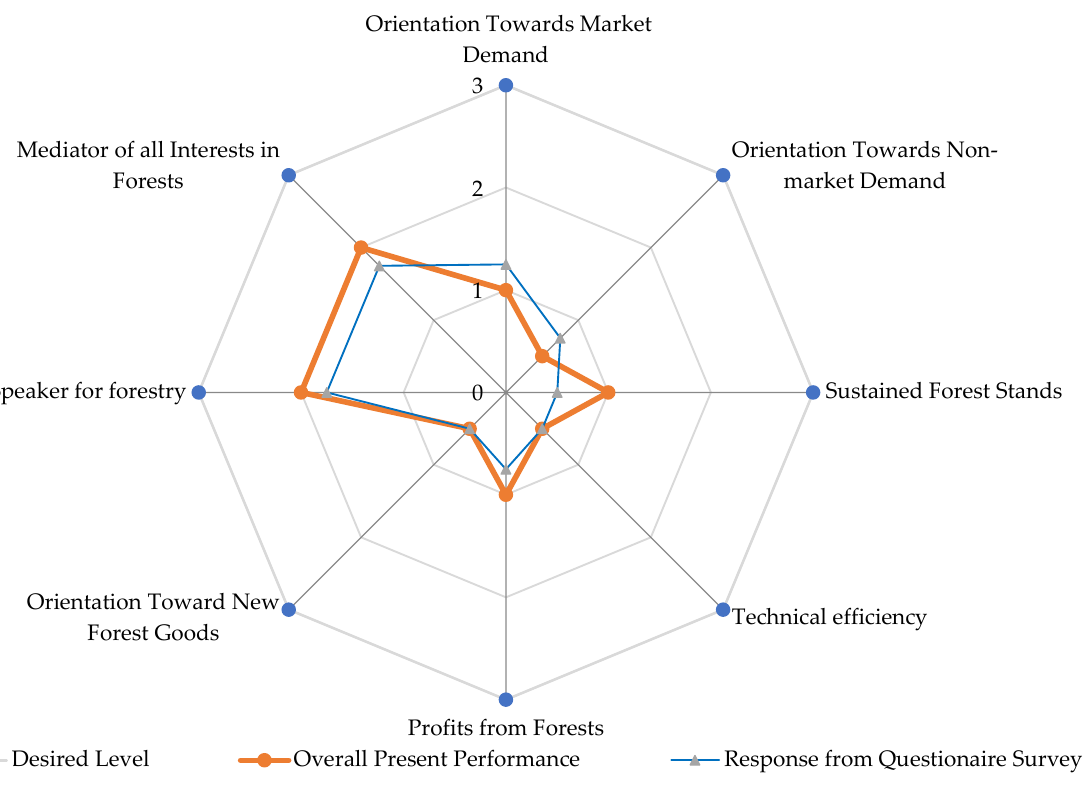
Figure 2. Community forestry performance against the 3L model criteria (national forest goals) in Nepal.